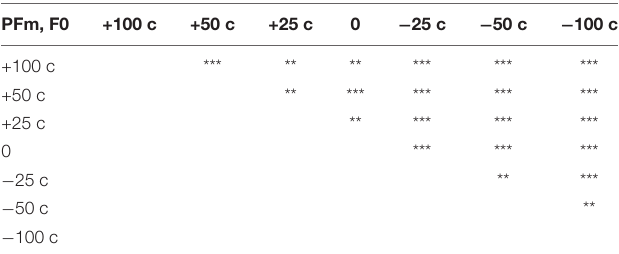
TABLE 3 | Summary of the results of post hoc analyses on significant effect of modification size for F0 in PFm (** p < 0.01, *** p <